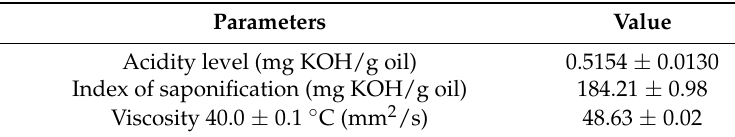
Table 1. Physical-chemical parameters of degummed oil of B. glabra.